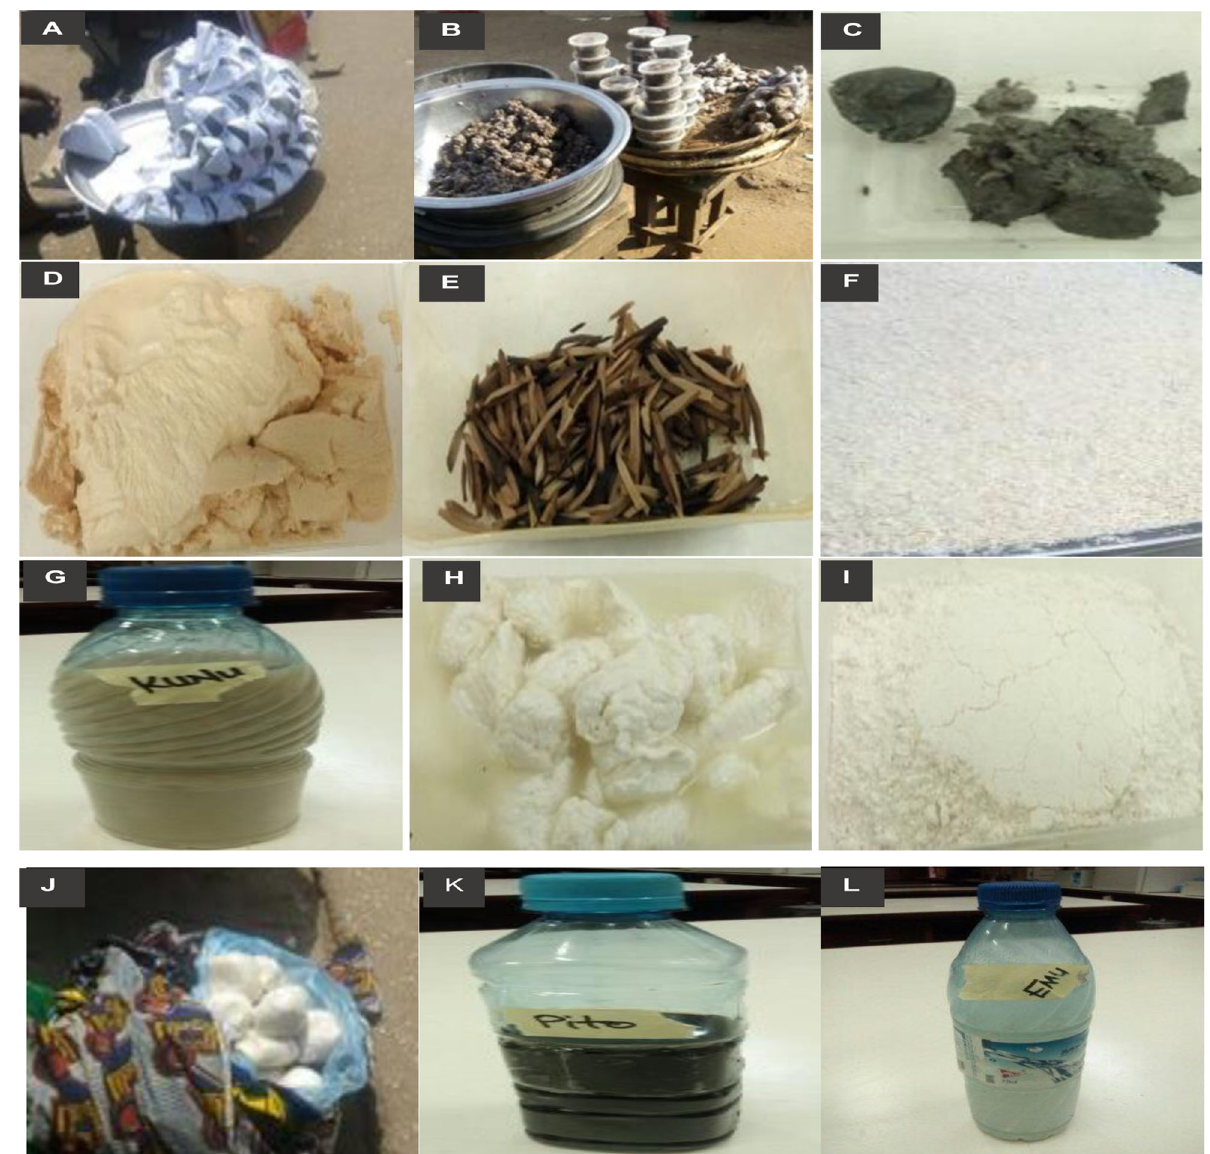
Fig. 1 Common fermented foods in Africa ( A = Eko, B = Iru, C = Ogiri, D = Ogi, E = Ugba, F = Gari, G = Kunu, H = Wara, I = Lafun, J = Fufu, K = Pito, L =